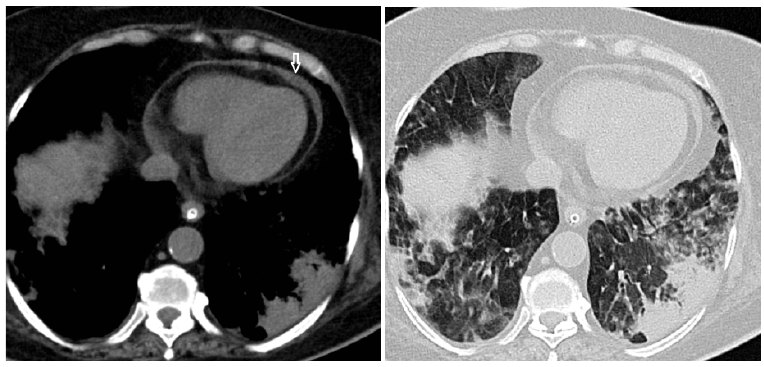
Figure 1. Pericardial effusion (white arrow) in a patient with a severe form of COVID-19 pneumonia.